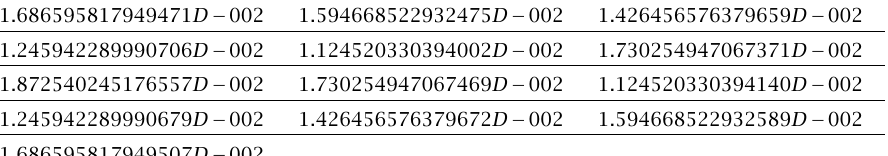
Table 3.7 . The errors with n = 13 , l = 0 . 5 on γ 1 .